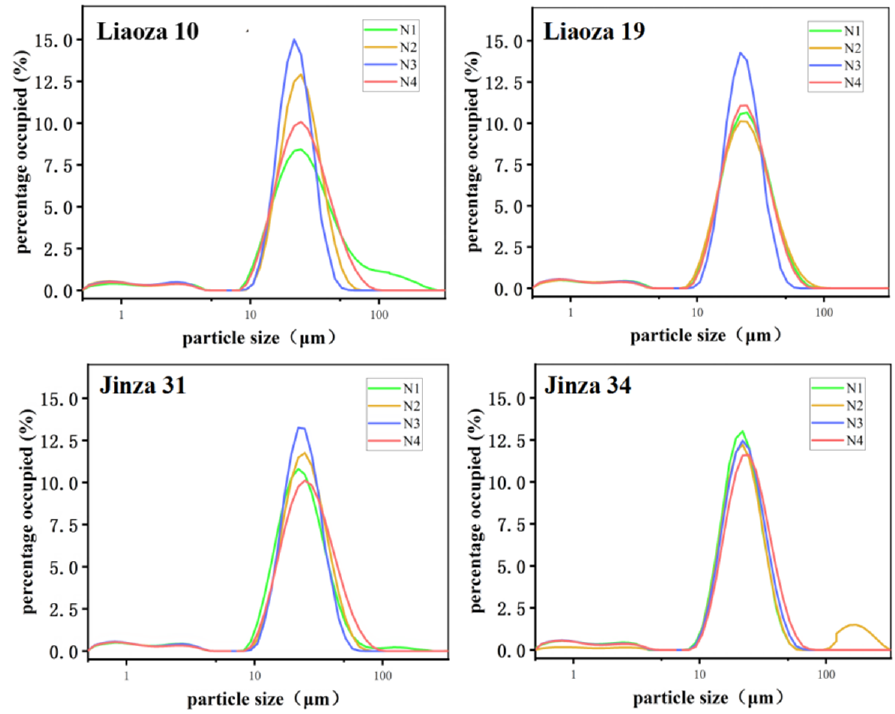
Figure 3. Effects of different nitrogen fertilizer levels on grain size distribution of sorghum starch. Table 1. Effect of nitrogenous fertilizer levels on sorghum starch morphology.